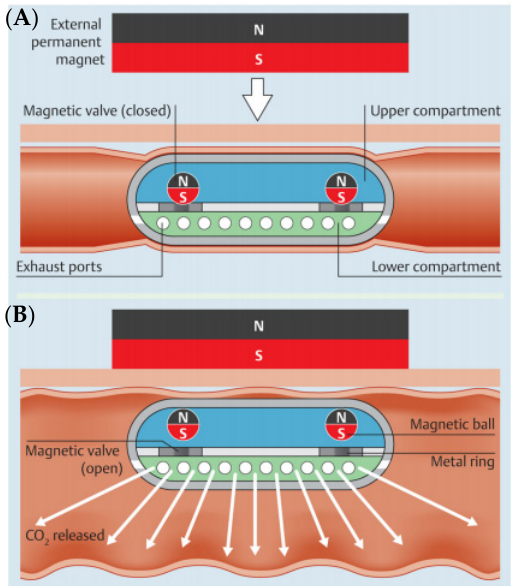
Figure 6. The insufflation capsule with two sections. ( A ) magnetic valves make a tight barrier between the compartments; ( B ) when activated with a permanent external magnet, the valves open to permit a mixture of the two reactants, releasing carbon dioxide. Adapted from Pasricha et al. [30] with permission from Thieme.